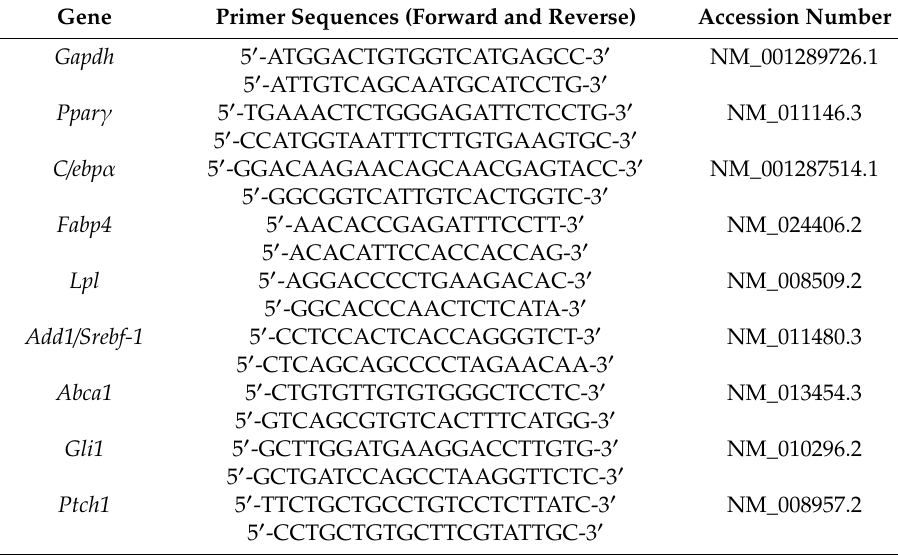
Table 1. Primer sequences for PCR